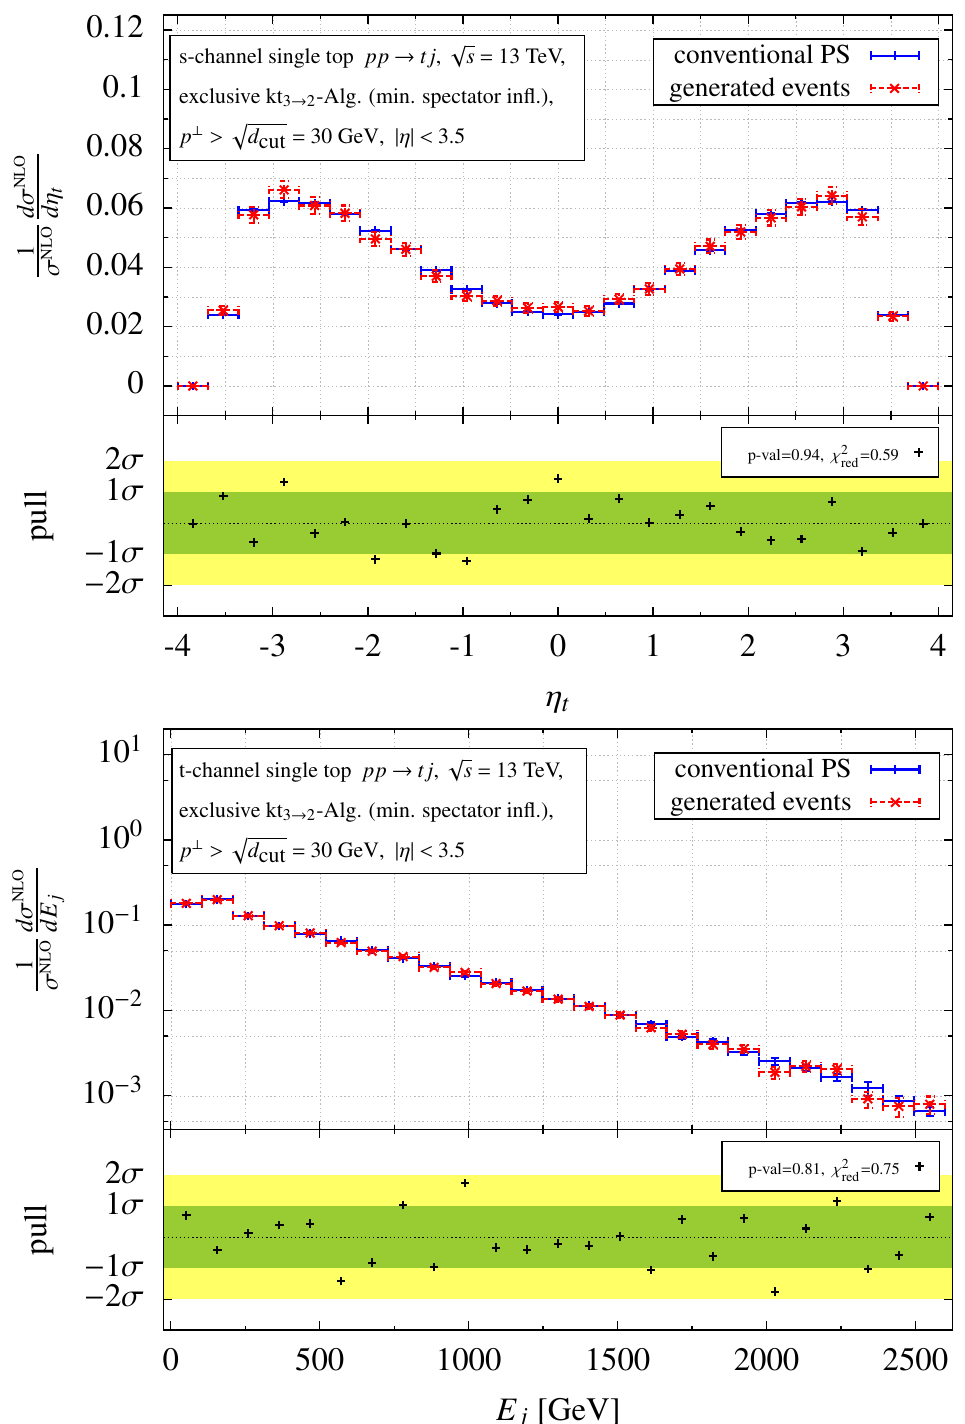
Figure 7 . Pseudo rapidity distribution of the top-tagged jet from exclusive s -channel single top production and energy distribution of the light jet from exclusive t -channel single top production calculated using a conventional parton level MC (blue, solid) compared to histograms (cid:12)lled with generated NLO events (red, dashed).